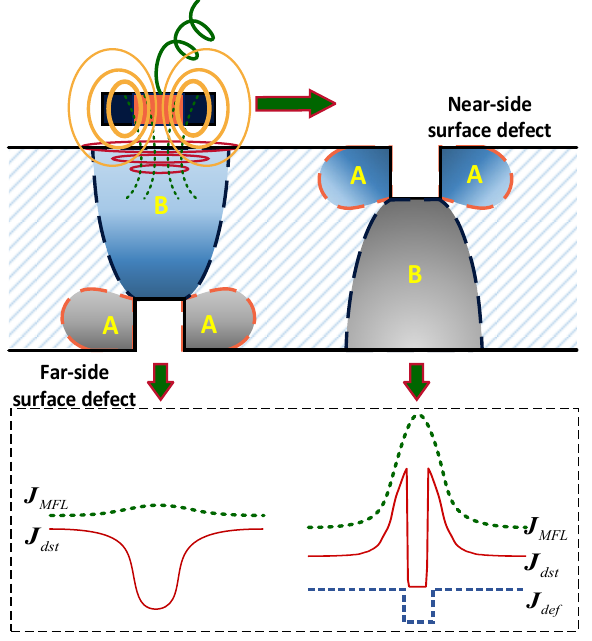
Figure 14. Signal source of the MB-ECT method for a far-side surface defect and a near-side surface defect.